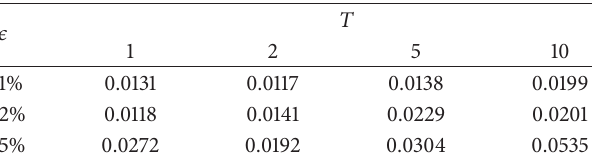
Table 3: Example 3: the relative errors with 𝑡 0 = 1𝑒−10 and 𝑚 = 100 for 𝛾 = 1/2